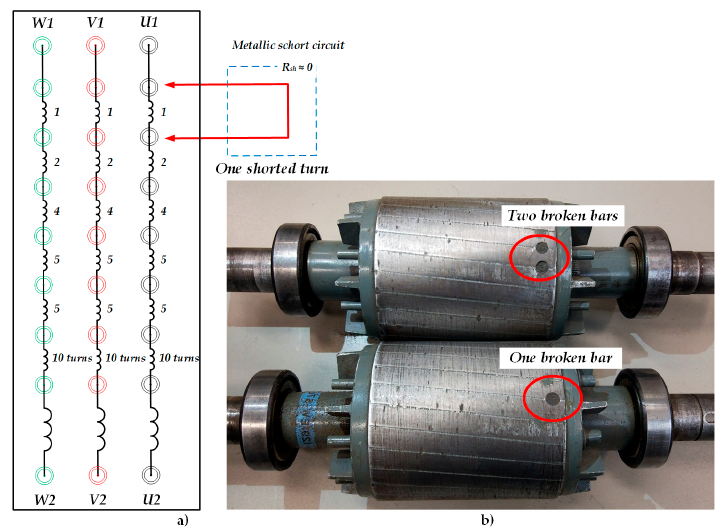
Figure 3. Experimental setup: ( a ) block diagram; ( b ) real view. PWM: pulse width modulation.